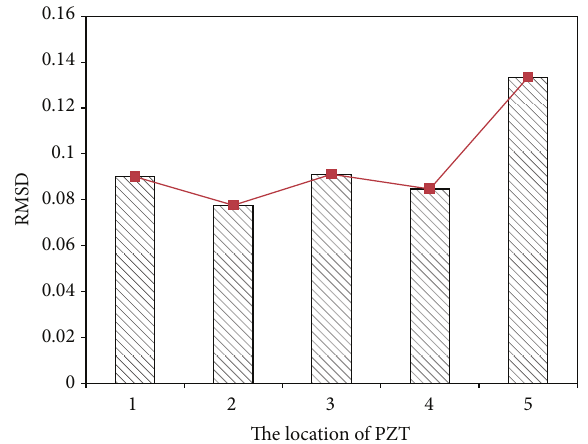
Figure 18: A damage metric chart of RMSD for damage.